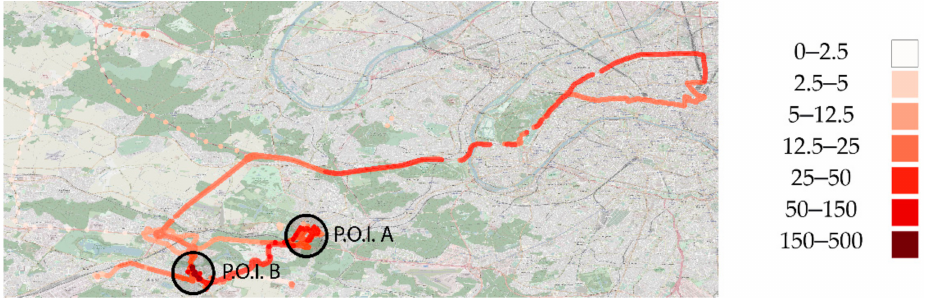
Figure 5. Spatial tracing of PM 10 ( µ g/m 3 ) for both periods A and